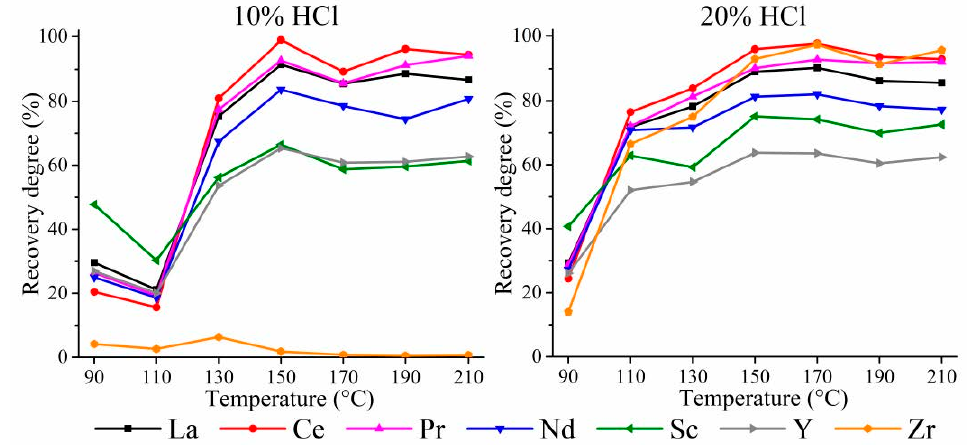
Figure 5. The effect of the temperature on the recovery degree of the minor elements for the SSAT sample using 10 and 20% HCl at S:L ratio = 1:11 for 60 min.